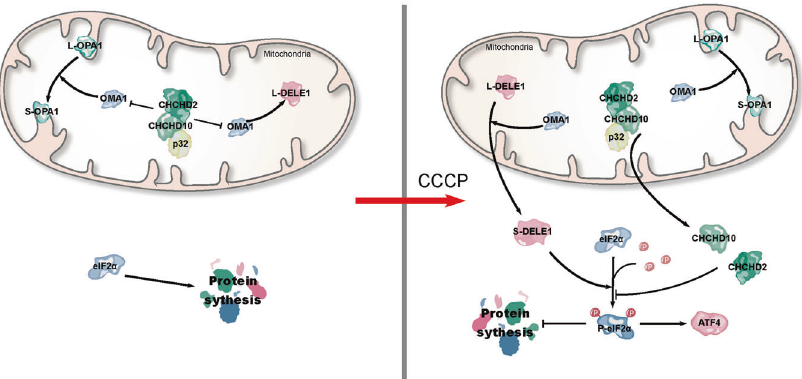
Fig. 7 Model of CHCHD2 and CHCHD10 regulating OMA1 activity and mtISR. CHCHD2 and CHCHD10 mainly suppress the OMA1 activity and inhibit phosphorylation of eIF2A at normal conditions by binding them, and loss of CHCHD2 and CHCHD10 activates OMA1 to cleavage OPA1 and DELE1; at stress conditions (loss of membrane potential), CHCHD2 and CHCHD10 increase and translocate from mitochondria to cytosol to suppress phosphorylation of eIF2A to inhibit